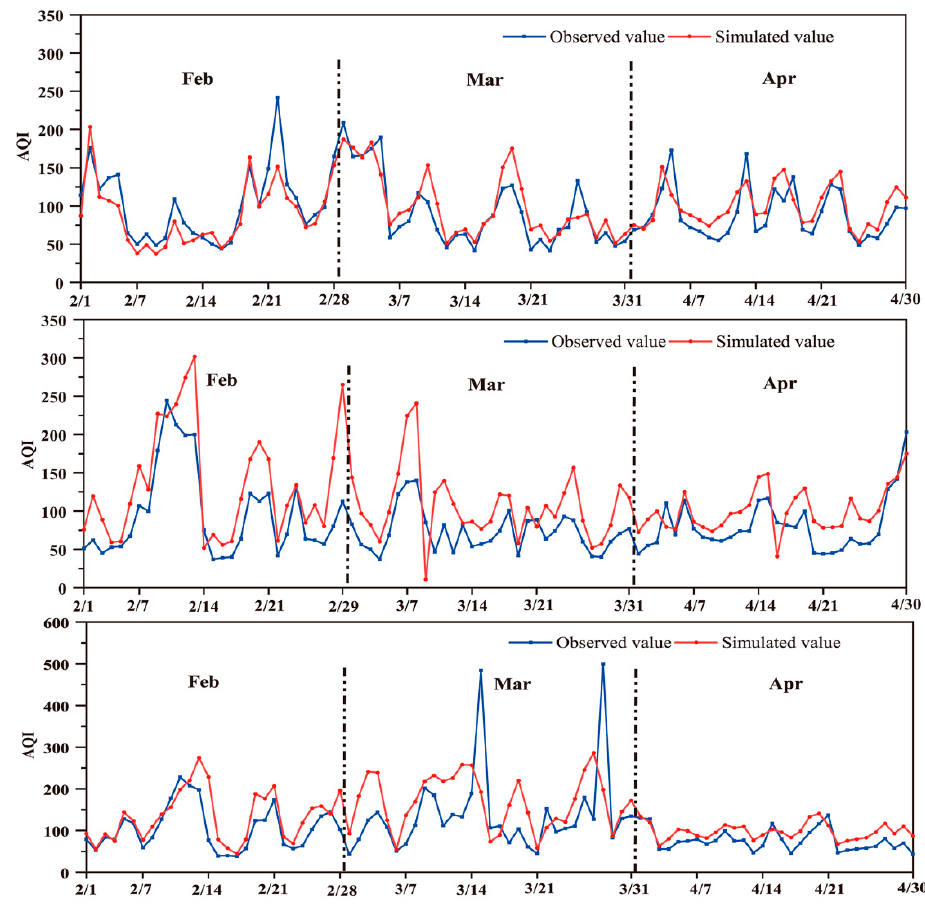
Figure 5. Simulated daily AQI values based on MLR models for February, March, and April 2019– 2021.